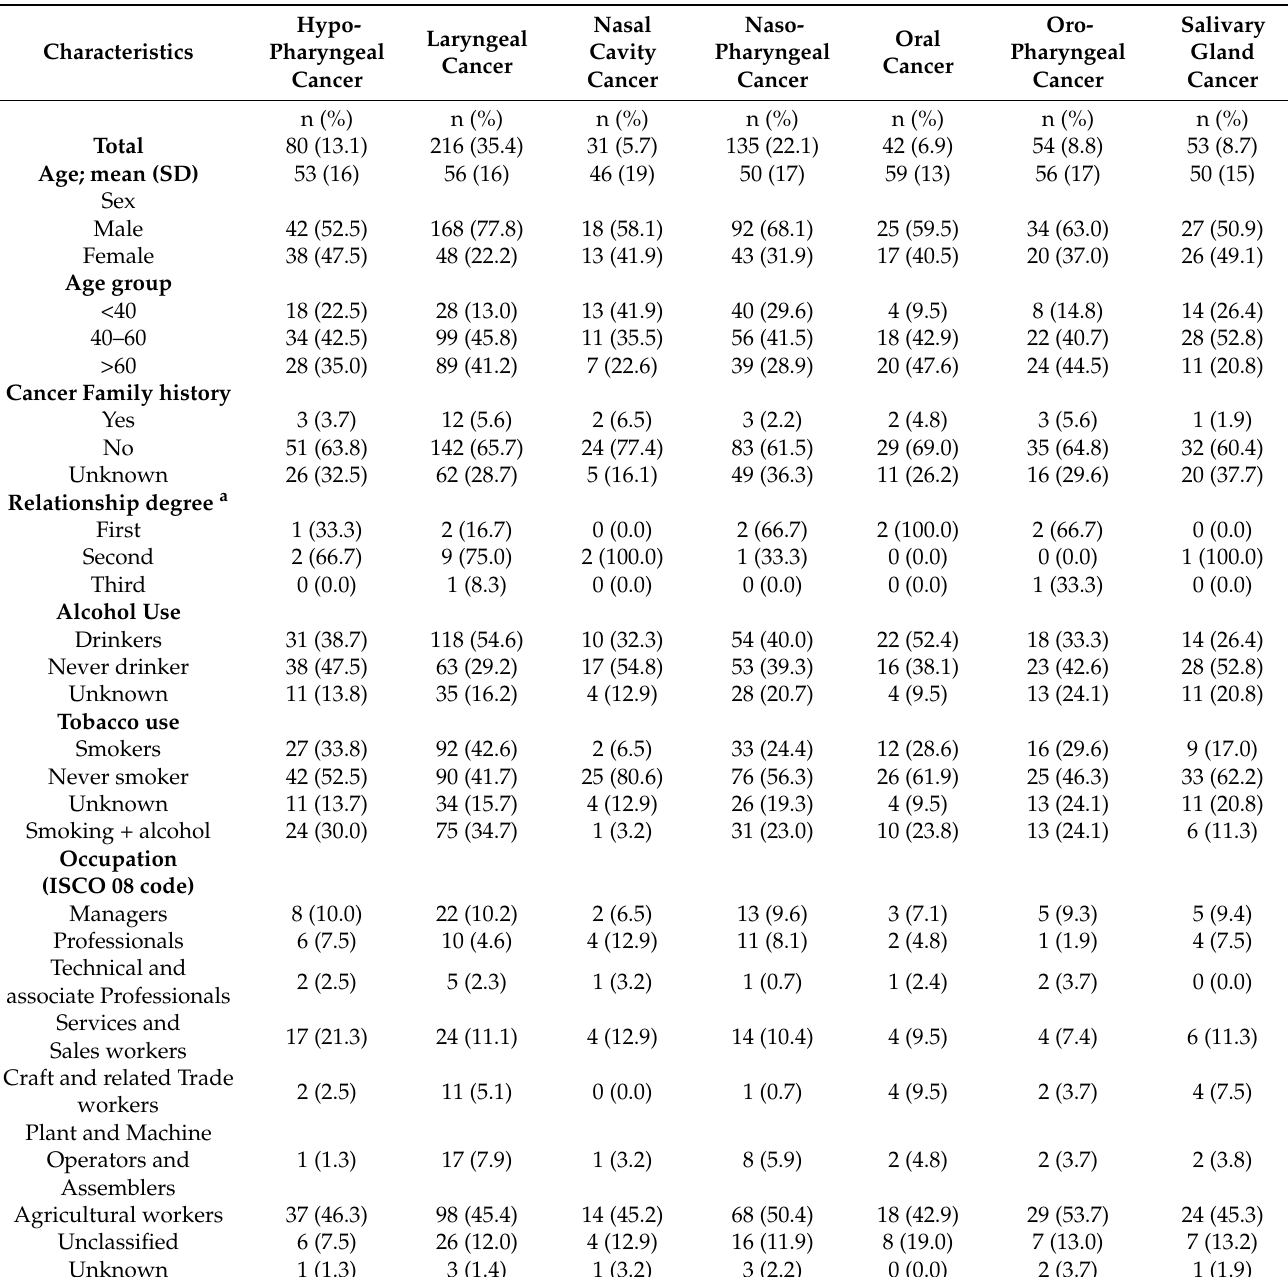
Table 2. Socio-demographic characteristics among head and neck cancer patients at the Tanzania cancer hospital 2019–2021. a Among those with family